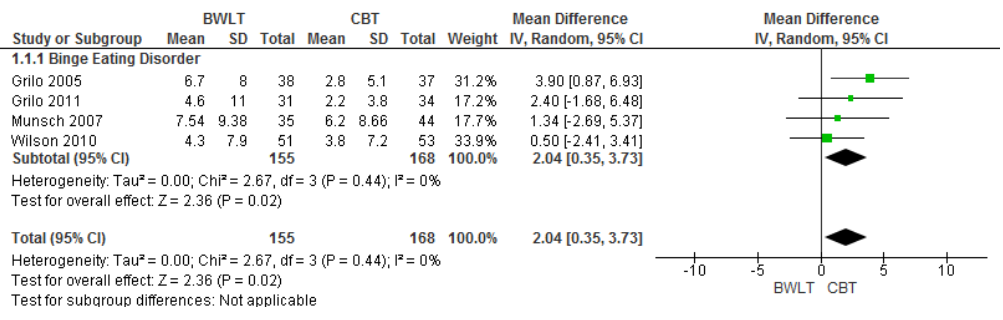
Figure 2. Behavioural Weight Loss Therapy versus Cognitive Behavioural Therapy ‐ Effects on binge eating frequency at the end of treatment in individuals with binge eating disorder.